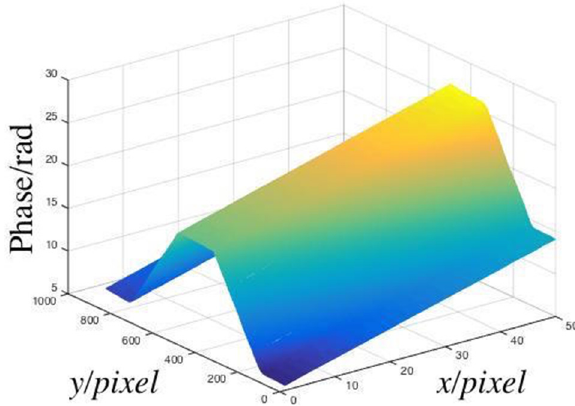
Figure 5. Phase of the measured object.